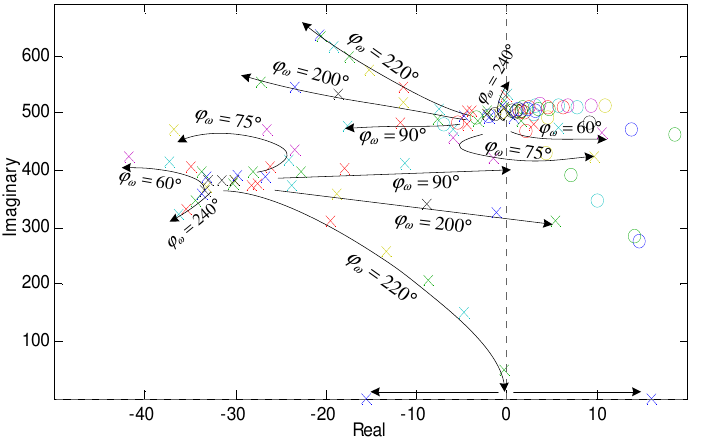
Figure 13. Poles and zeros of the AMB system with GPF at speed of 80